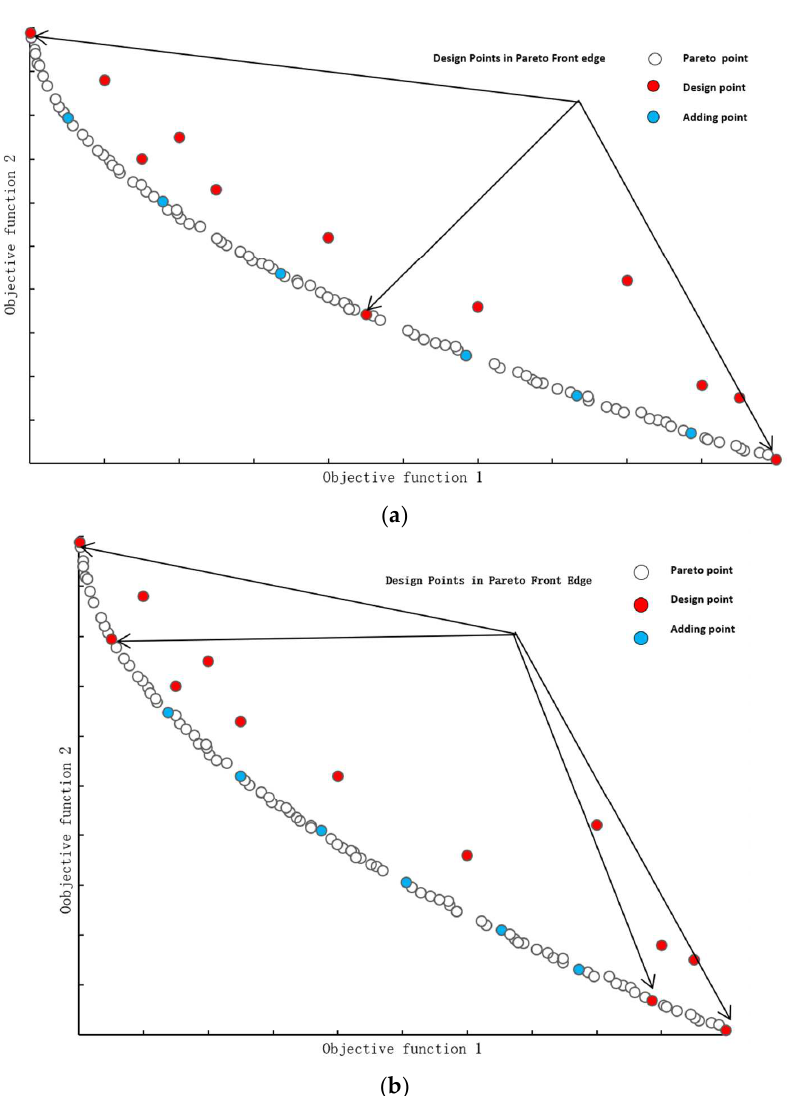
Figure 2. Pick extra sample points in Pareto points. ( a ) Scenario 1. ( b ) Scenario 2.